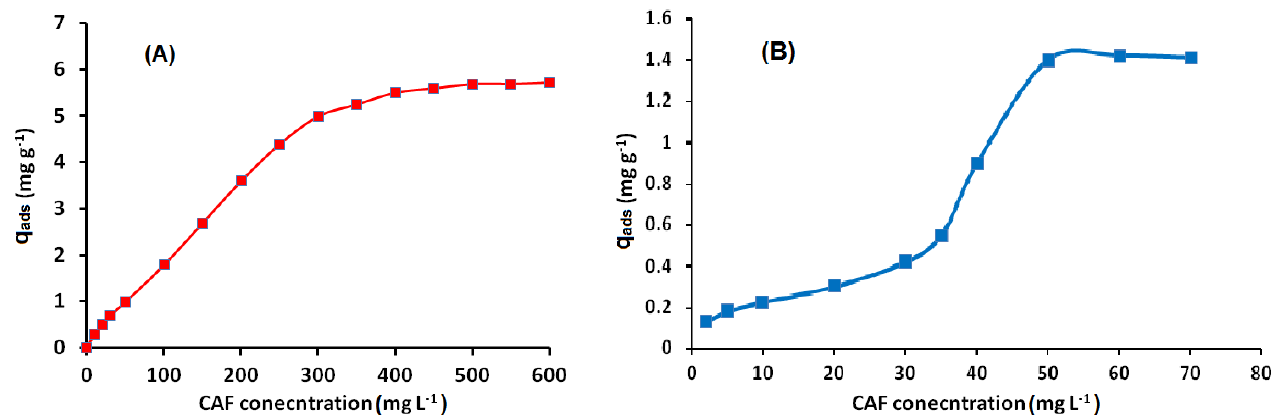
FIGURE 12 - Extraction isotherms for CAF with: (A) AY-GPUF and (B) AY-IPUF